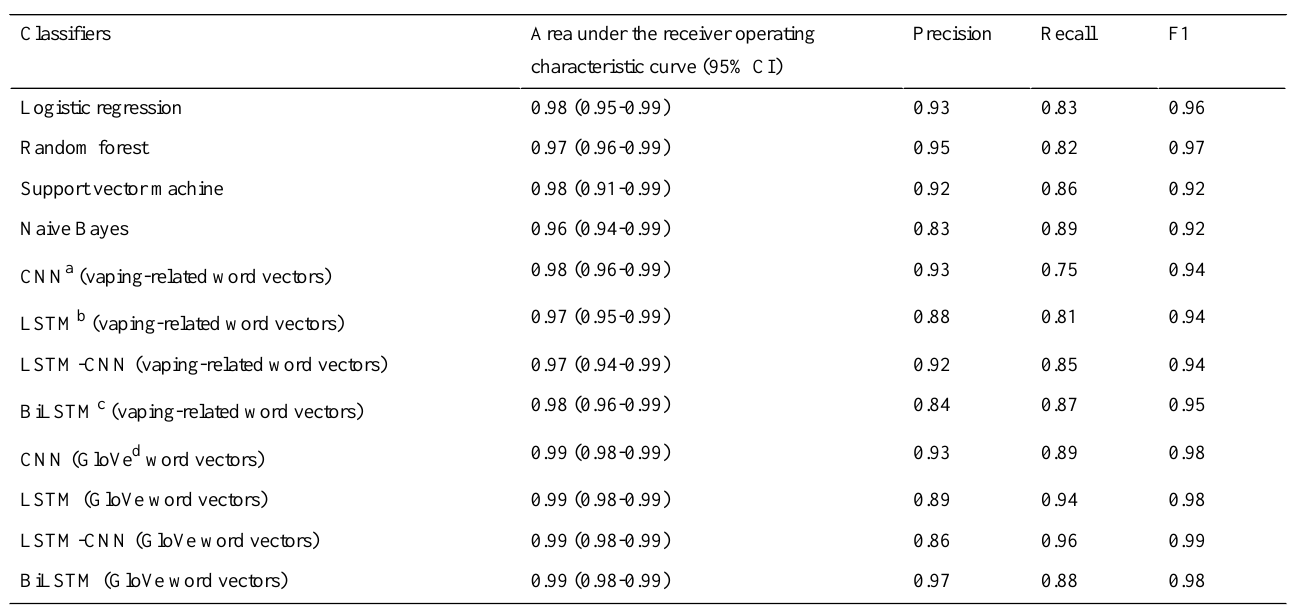
Table 7. Performance of commercial